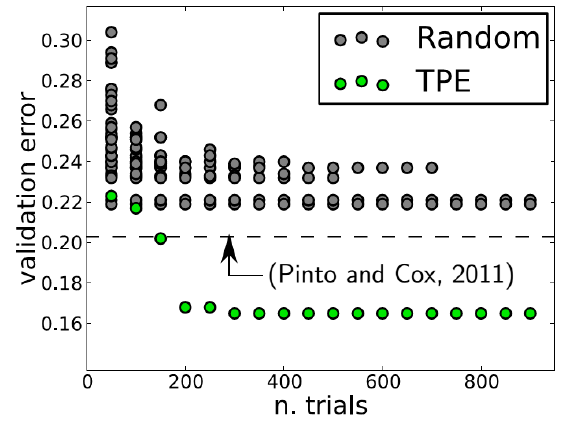
ff erent search techniques on data sets LFW Figure 6. Performance of different search techniques on data sets LFW [18]. Figure 6. Performance of di